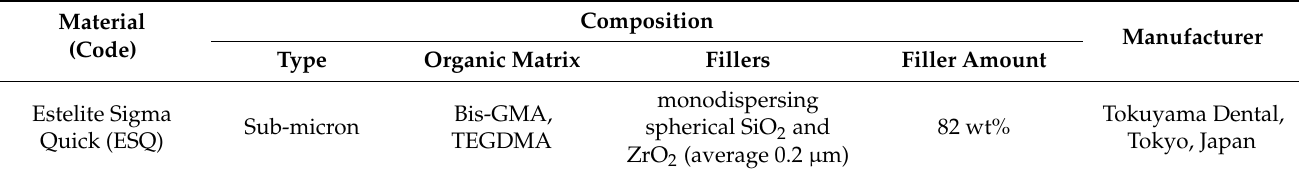
Table 1. Description of resin composites used in the